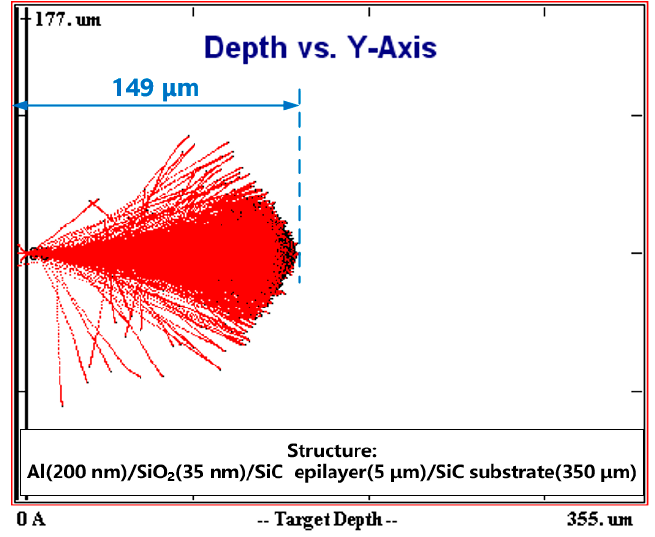
Figure 2. SRIM simulation of the MOS Capacitors injected by a 5MeV Proton beam.